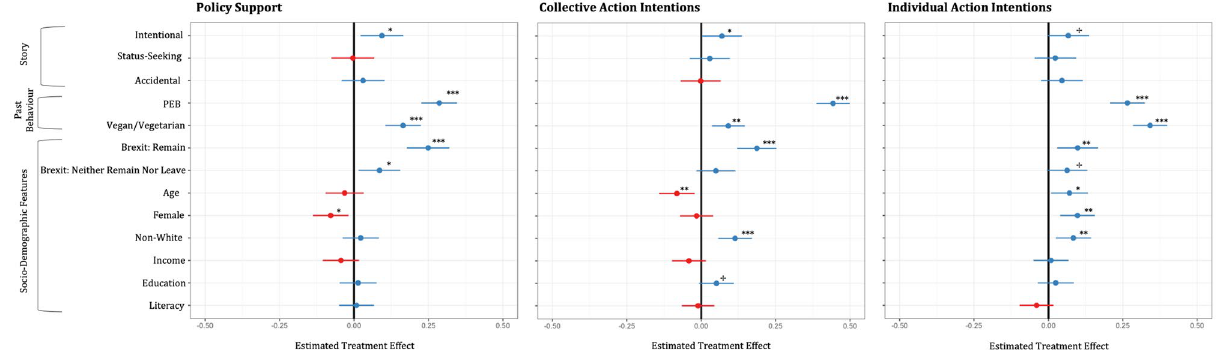
Figure 3. Effect of stories on climate policy support and action intentions. † p < 0.1, * p < 0.05, ** p < 0.01, *** p < 0.001. Estimates are standardised coefficients. Error bars represent 95% confidence. Blue and red represent positive and negative effects respectively. All outcomes measured using composites, on Likert scales of 1(not at all) to 7(extremely). Omitted categories: Control group, non-vegetarian/vegan diet, Brexit: leave, male, white. Scales for ordinal/numerical variables: PEB (Past environmental behaviour)—0–2 scale, Age—continuous numerical variable, Income—Likert scale of 1(less than £20,000) to 6 (more than £100,000), Education—Likert scale of 1(less than O level) to 10 (Doctorate or other professional degree), Literacy—Likert scale of 1 (no proficiency) to 6 (native/bilingual